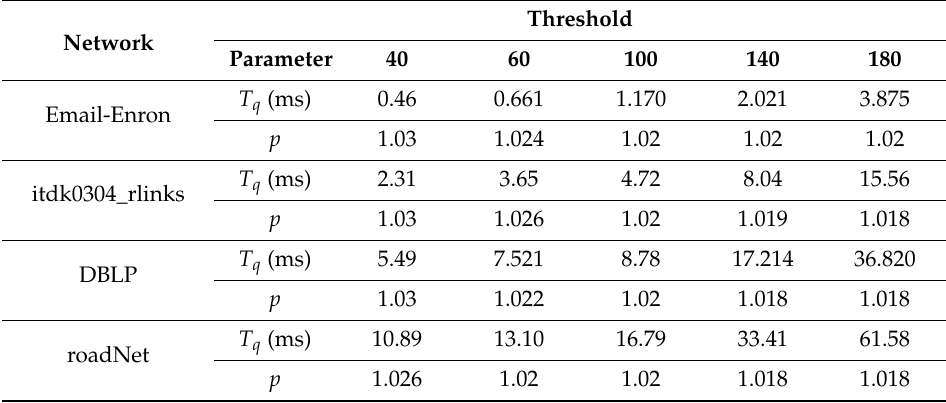
Table 4. Comparison of di ff erent